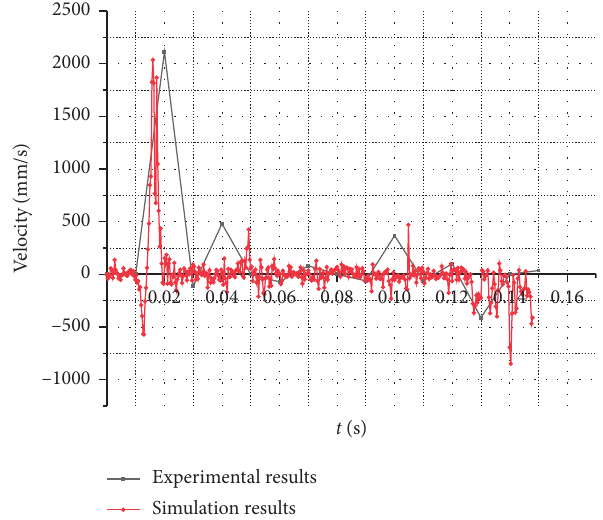
Figure 21: Comparison of the velocity-time history curves of the 35th coil.